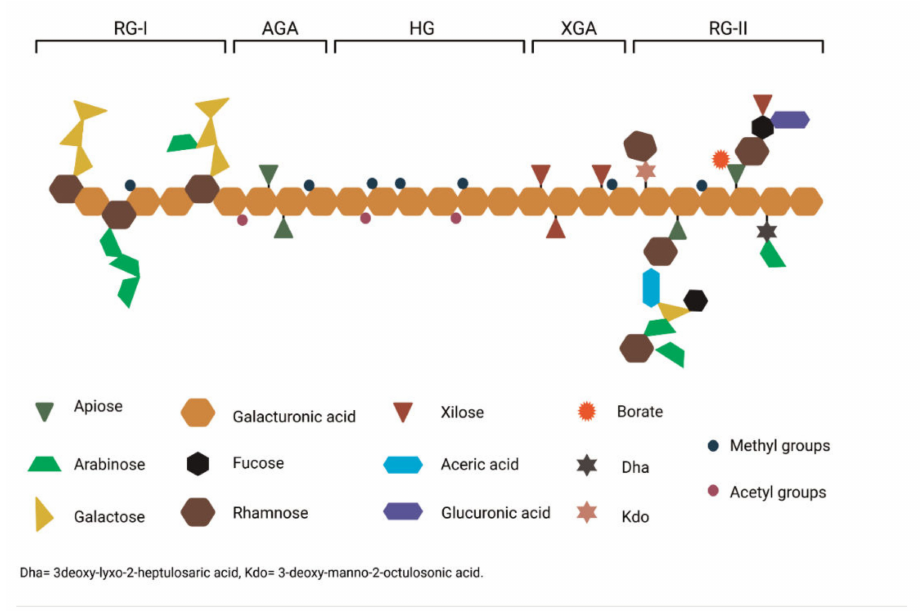
Figure 1. Molecular structure of